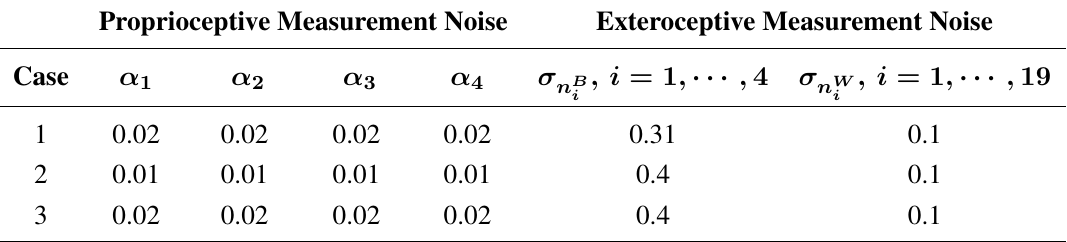
Table 3. Tuning parameters related to measurement